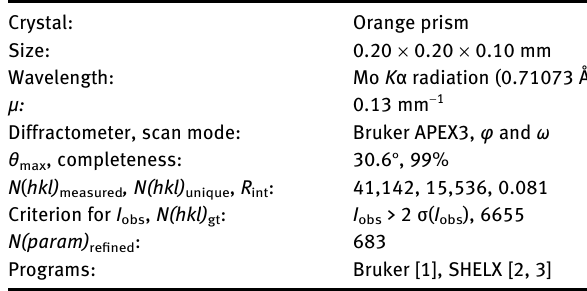
Table  : Data collection and handling. Crystal: Orange prism